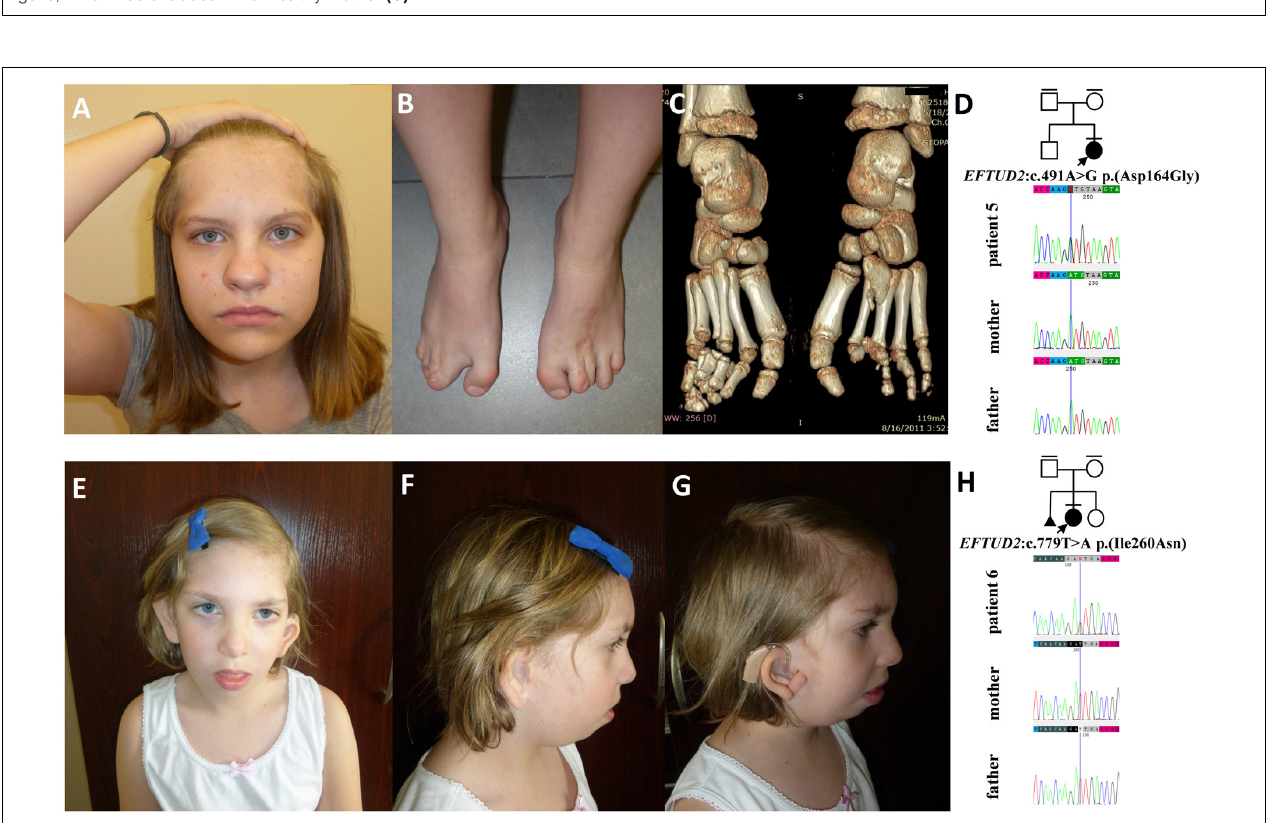
FIGURE 5 | Clinical characteristics and segregation results of patient 5 (A–D) and 6 (E–H) affected by acrofacial dysostosis Guion-Almeida type. Patient 5 carries a heterozygous variant c.491A > G p.(Asp164Gly) within the EFTUD2 gene, which occurred de novo (D) whereas patient 6 carries a heterozygous variant c.779T > A p.(Ile260Asn) within the EFTUD2 gene, which also occurred de novo (H) .